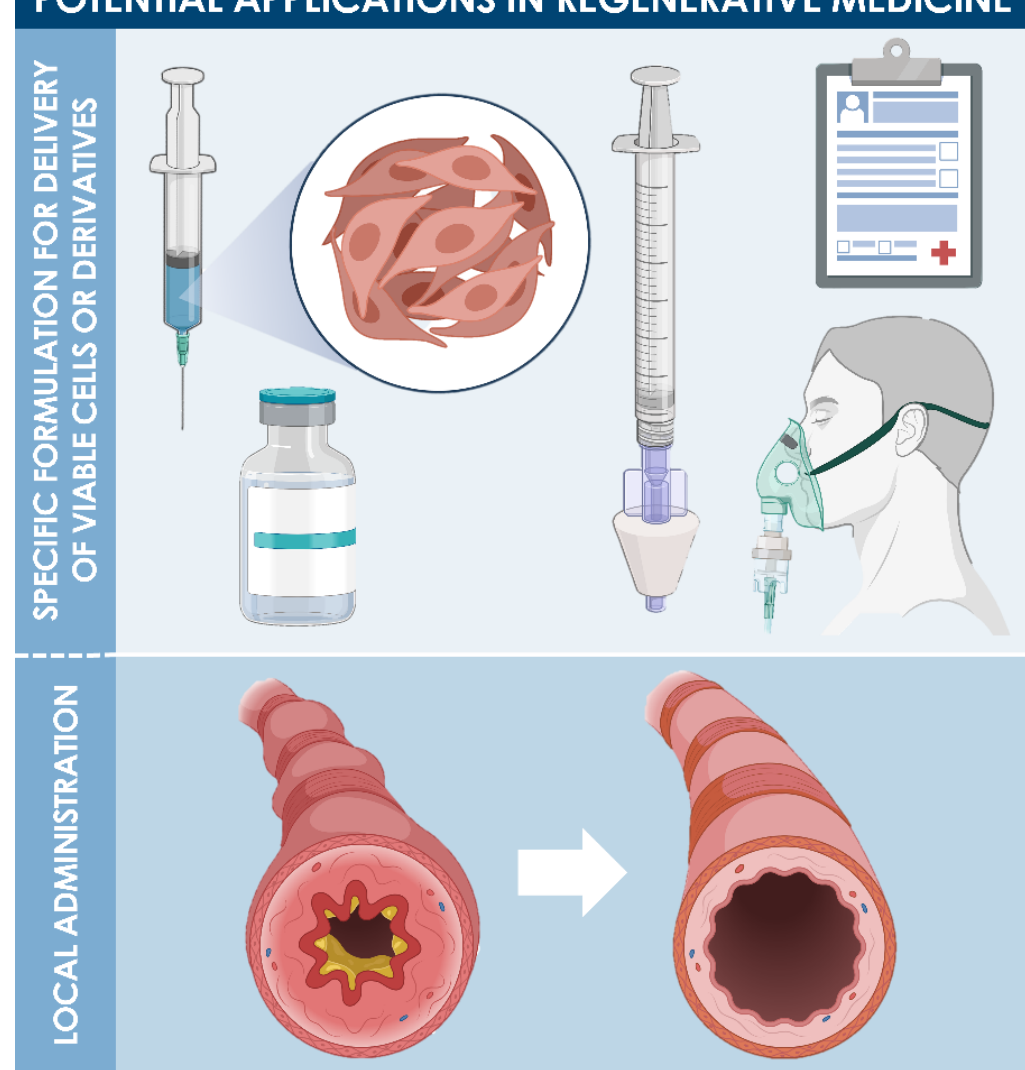
Figure 8. Potential applications and postulated effects of diploid progenitor cells in respiratory tract regenerative medicine. Appropriate cell-based product formulations are considered for local delivery in view of obtaining poten- tial anti-inflammatory or tissue modulation effects during recovery. The overall goal of local product administrations would be to limit airway inflammation and reduce tissue scarring upon recovery for optimal structural and functional lung tissue